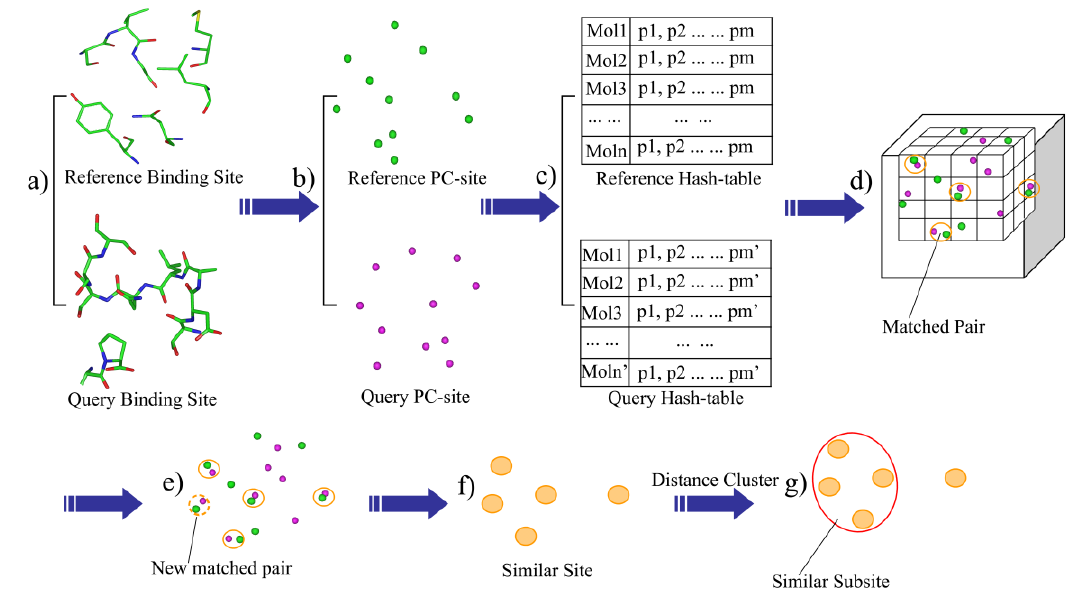
Figure 1. The flowchart of BSMM.